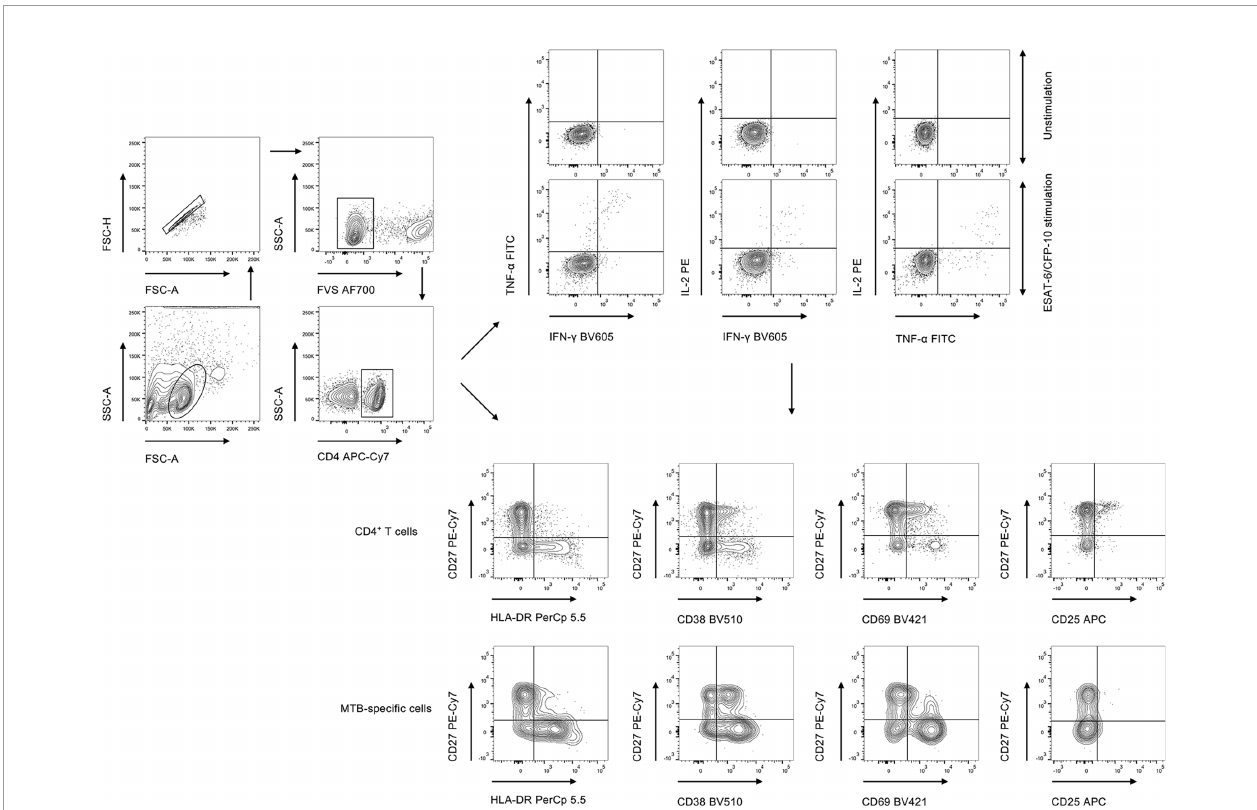
FIGURE 1 | The gating strategies for cytokine expression and activation phenotype in the current study. FVS, fi xable viability stain; MTB, Mycobacterium tuberculosis